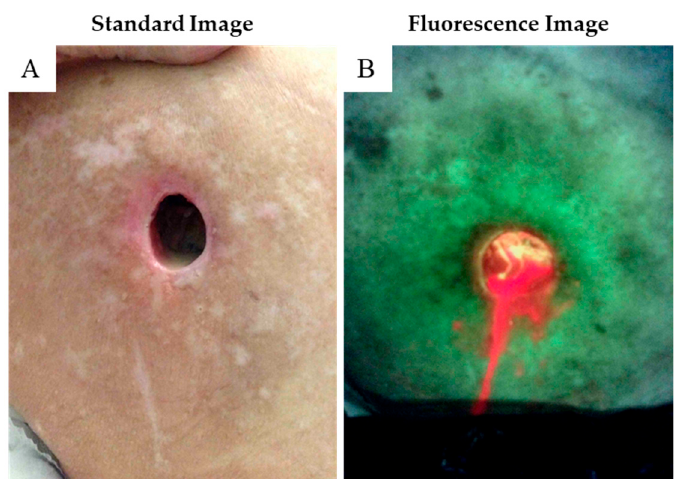
Figure 4. Case 3. ( A ) This wound over the right greater trochanter measures 1.5 cm and has clear serous drainage. ( B ) Drainage from the wound shows red autofluorescence of bacterial infestation, not recognized by physical examination alone. This proved to be a periprosthetic total joint infection.